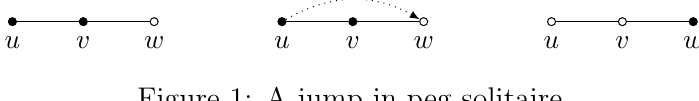
Figure 1: A jump in peg